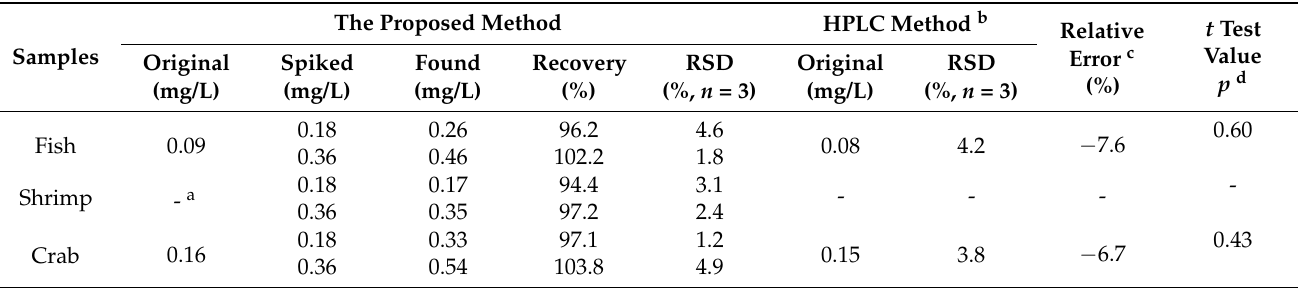
a : no detected; b : The analytical separations were achieved using a reverse phase C18 column. The mobile phase was acetonitrile and 1.2 mg/L NaH 2 PO 4 (26:74, v / v -), the flow rate was 1.0 mL/min and the detection wavelength was 355 nm; c : ( I proposedmethod − I HPLC )/ I HPLC , I represents test result; d : value of t test in the table with confident interval 95%; p > 0.05 indicating no significant